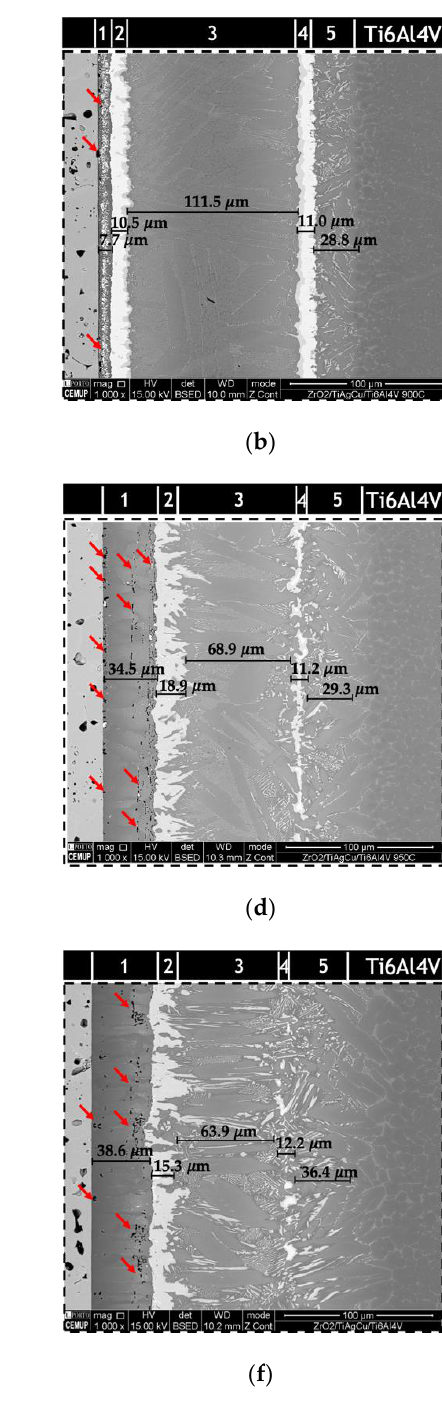
Figure 3 . SEM images of the of ZrO 2 /Ti6Al4V alloy brazed interfaces processed at: ( a , b ) 900 °C, ( c , d ) 950 °C and ( e , f ) 980 °C. ( c , d ) 950 ◦ C and ( e , f ) 980 ◦